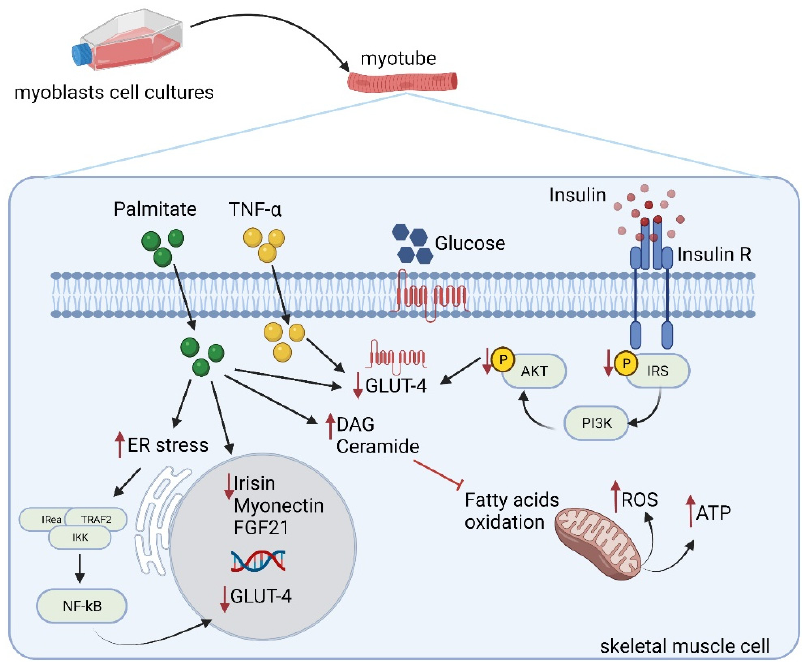
Figure 2. Schematic representation of insulin resistance induction in skeletal muscle cells. In the presence of insulin resistance, skeletal muscle insulin sensitivity is reduced due to impaired IR function and GLUT-4 translocation. Moreover, chronic exposure to high insulin concentrations impairs myoblasts metabolism. Palmitate is known to induce insulin resistance by impairing glucose uptake and reducing GLUT4 expression in skeletal muscle. Indeed, palmitate induces a significant reduction of insulin-stimulated Akt phosphorylation as well as GLUT-4 mRNA expression. In addition, palmitate promotes myotubes loss and impaired expression of irisin, myonectin, and FGF-21. Moreover, acute palmitate treatment promotes ER stress; disturbed ER homeostasis activates an adaptive process called unfolded protein response, leading to the formation of the IREa–TRAF2–IKK complex, which activates NFkB to translocate into the nucleus, downregulating GLUT-4 gene expression. Similarly, TNF- α has been reported to induce insulin resistance in skeletal muscle cells. Indeed, differentiated primary muscle cells cultured in the presence of TNF- α showed GLUT-4 translocation impairment. Red arrows indicate positive or negative modulation of downstream targets. Red line indicates an inhibitory effect mediated by DAG and ceramide on fatty acids oxidation. Abbreviations: ER, endoplasmatic reticulum; FGF21, fibroblast growth factor 21; ROS, reactive oxygen species; TNF- α , tumor α necrosis factor; NFKB, nuclear factor kappa B; TRAF2, TNF receptor-associated factors; IKK, I kappa B kinase; DAG, diacylglycerols; IRea, serine/threonine- protein